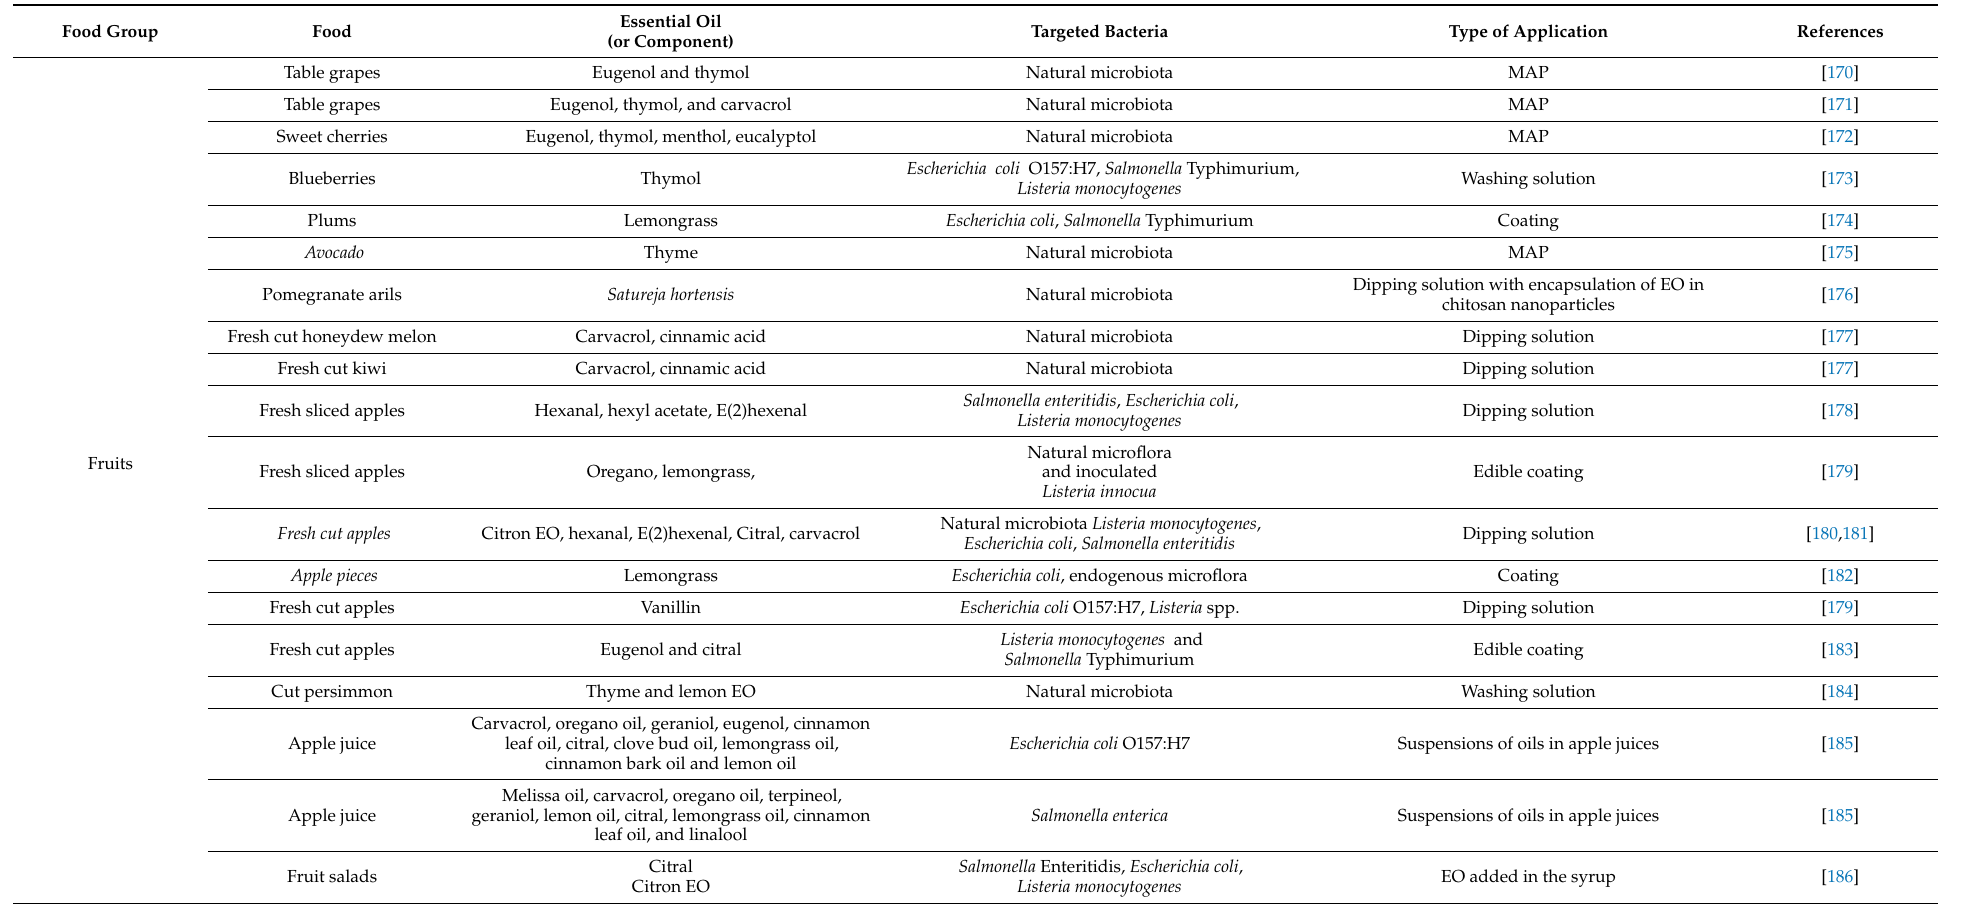
Table 4. Overview of studies testing realistic applications of essential oils or their components as antibacterial agents in minimally processed fruits and